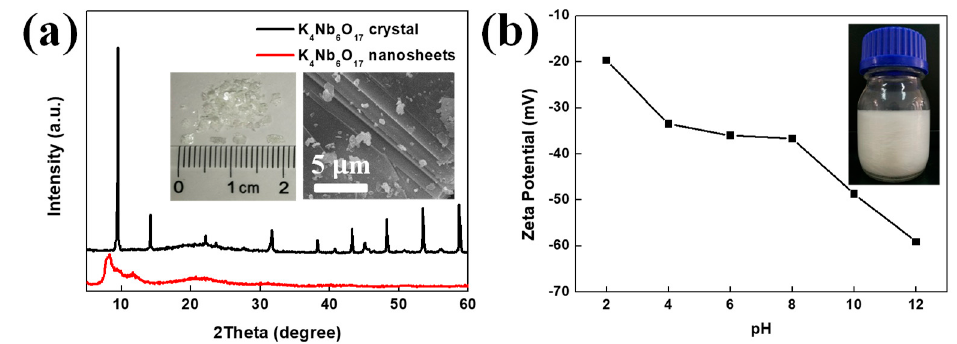
Figure 1. ( a ) X-ray diffractometer (XRD) spectra of K 4 Nb 6 O 17 crystal and K 4 Nb 6 O 17 nanosheets. Inset was the optical photograph (left) and SEM image (right) of K 4 Nb 6 O 17 crystal. ( b ) Zeta potential of K 4 Nb 6 O 17 nanosheets dispersion. Inset was the single to few-layer dispersion in water (60 mg mL − 1 ).